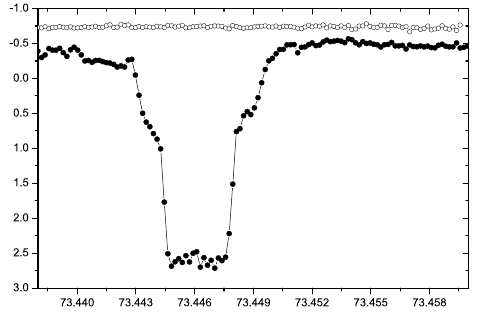
Figure 1: White-light photometric observations of V2301 Oph obtained on Feb. 15, 2012 by using the 2.4- m telescope in Lijiang observational station of Yunnan Observatories. Solid dots refer to the magnitude dif- ferences between V2301 Oph and the comparison star, while open circles to those between the comparison and the check stars.